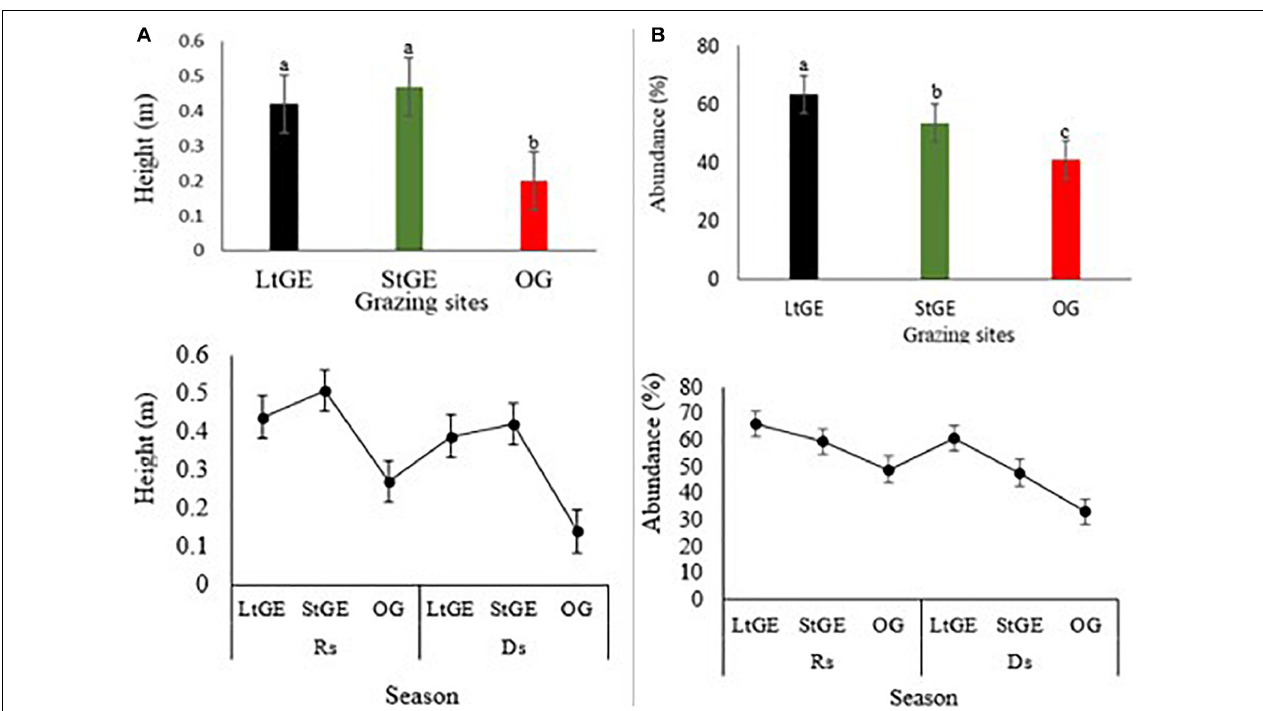
FIGURE 2 | Response of height (A) and abundance (B) of grass species under two treatments: grazing enclosure (short and long) and open-grazing of grassland types in relation with seasonal variation. Note: LtGE, long-term grazing enclosure; StGE, short-term grazing enclosure; OG, open-grazing; Rs, rainy season; Ds, dry season. Scatter plots show seasonal variations and bar plots attached show the yearly average value of grass characteristics. Error bars are shown by standard error. Different lowercase letters within bar plots indicate differences with a significant level ( P < 0.05) between the